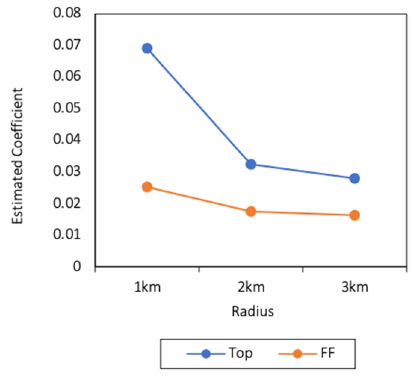
Figure 3. Estimated coefficients of the number of Tops and FFs within 1, 2, and 3 km of the urban subsample.